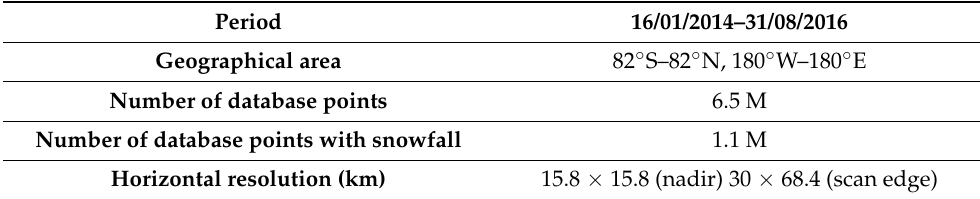
Table 2. Characteristics of the ATMS–CPR